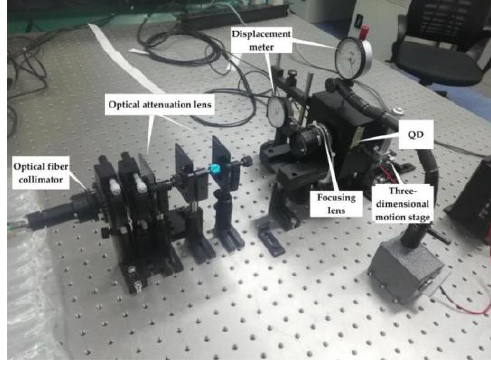
Figure 7. The experiment platform.